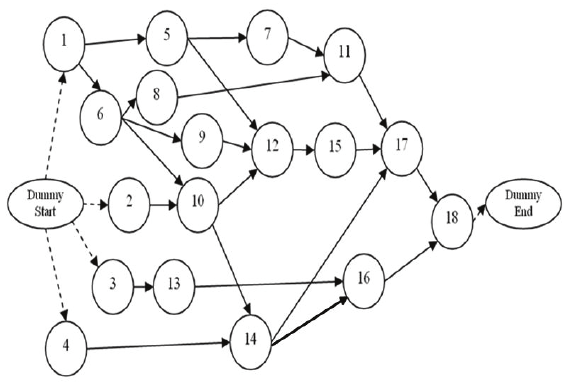
Fig. 8. Network of second case study